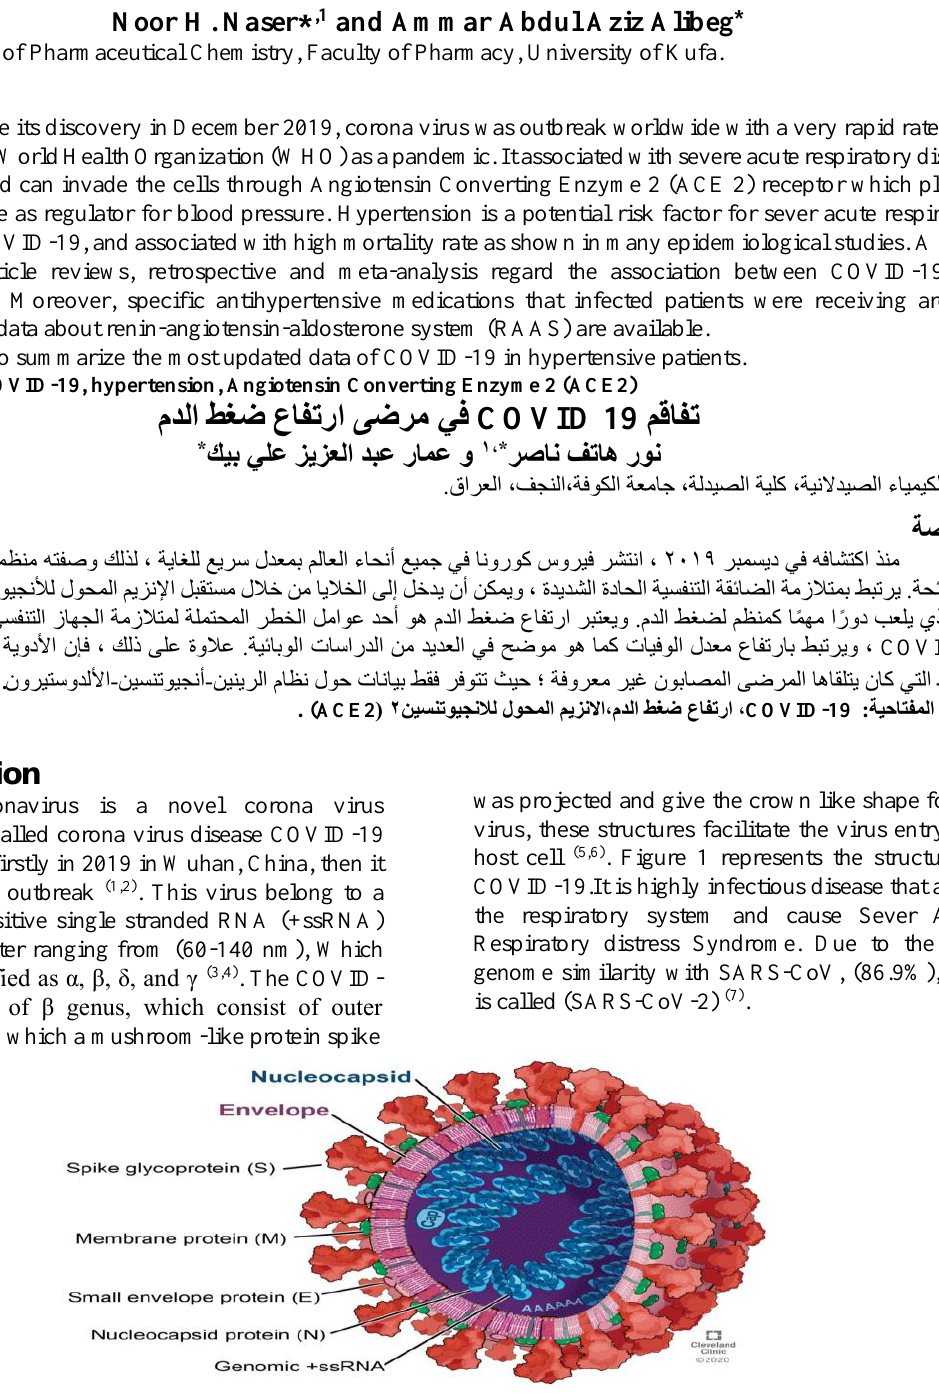
Figure 1. Structure of corona virus